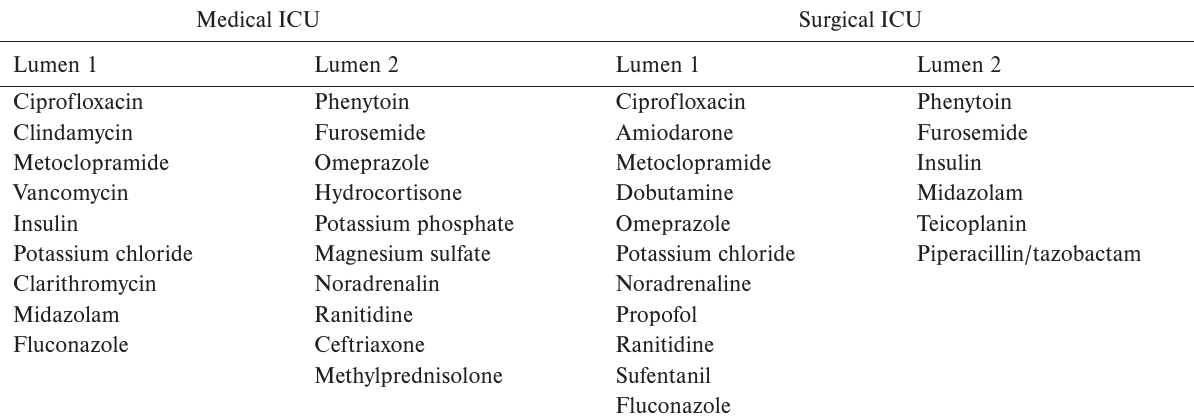
Table 4. Possible distribution of IV drugs in different lumens of a